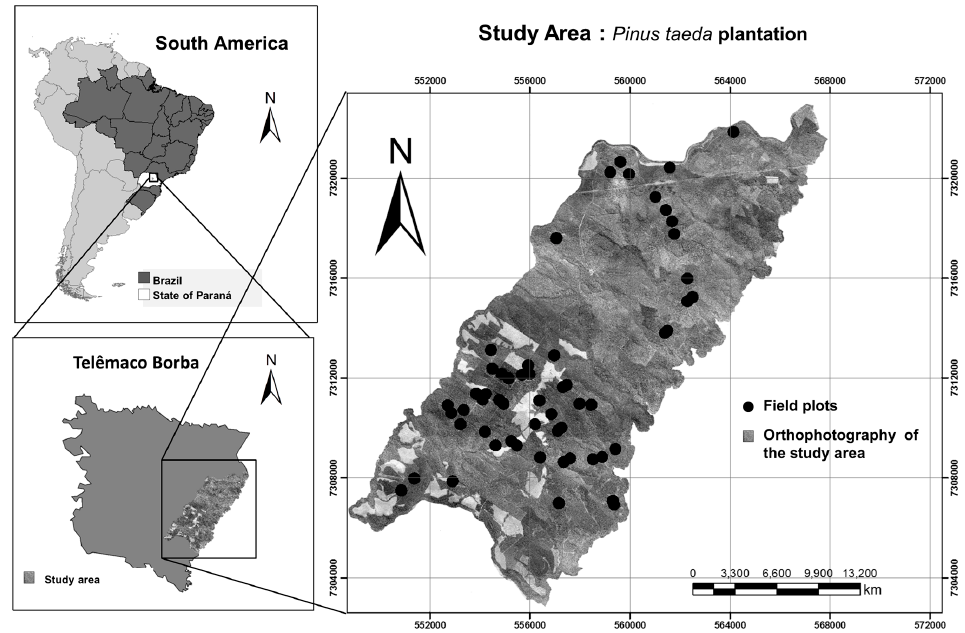
Figure 1. Location of study area in Telêmaco Borba, Paraná, Brazil. The black dotes indicate the location of the Pinus teada stands.